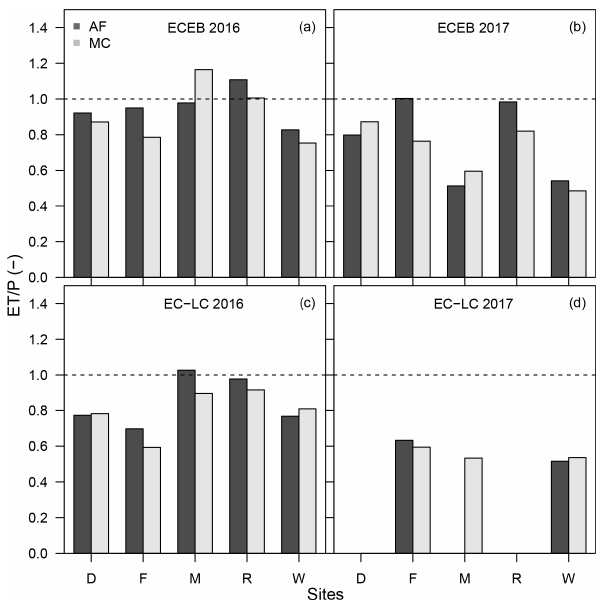
Figure C5. Bar plot of the evapotranspiration index for the ECEB method for the years 2016 (a) and 2017 (b) and for the EC-LC method for 2016 (c) and 2017 (d) for the sites, e.g. Dornburg (D), Forst (F), Mariensee (M), Reiffenhausen (R), and Wendhausen (W). The dashed line indicates an evapotranspiration index of one. Evap- otranspiration indices for Dornburg AF and MC, Mariensee AF, and Reiffenhausen AF and MC in 2017 are missing due to instrument